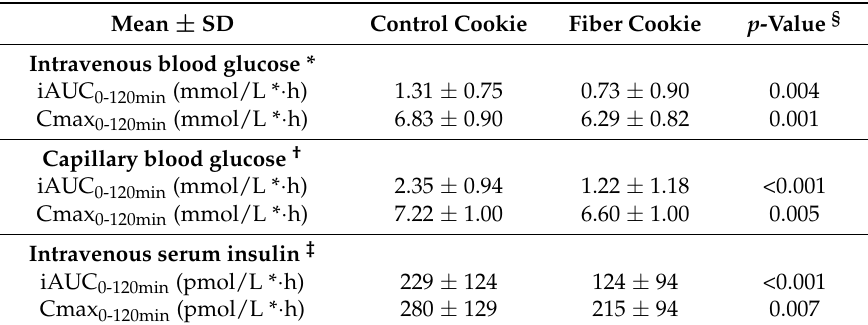
Table 3. Post-prandial glucose and insulin iAUC and Cmax §